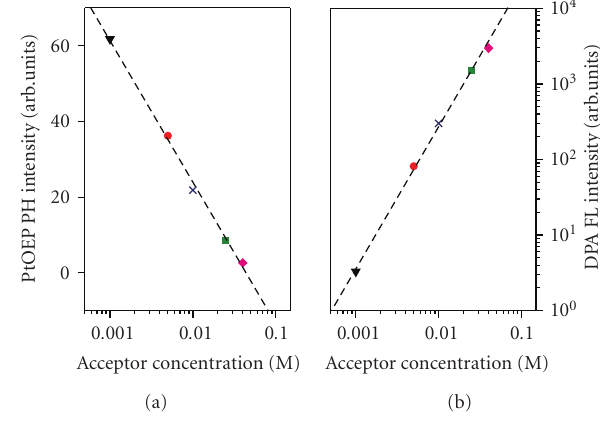
Figure 2: (a) DPA FL spectrum and (b) PtEOP PH intensity at di ff erent DPA concentration in PtOEP (1 . 4 × 10 − 4 M)/1,1,1- Trichloroethane solution. Spectra have been collected at RT exciting the solution at 532nm.